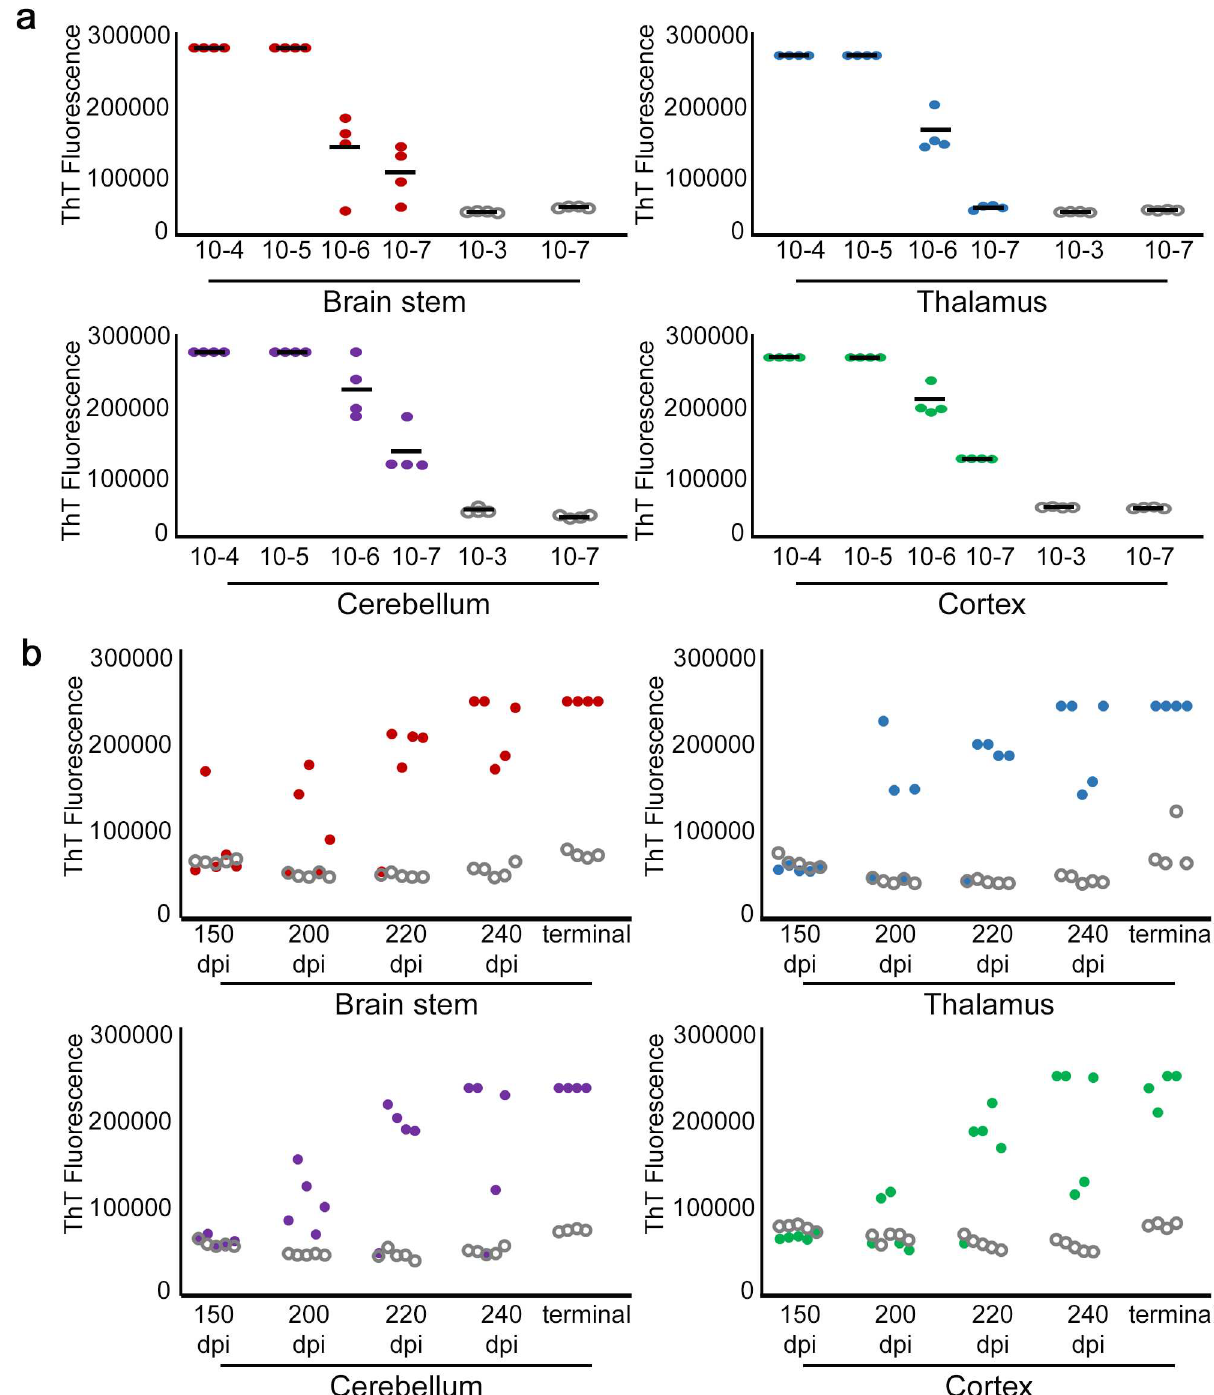
Fig 5. Neither quantity nor time of exposure of misfolded prion seeds are responsible for restrictedneurodegeneration. (a) RT-QuIC titration of brain regionhomogenates ( n = 4) shows that all brain regions dilute to a concentration of at least 0.001%(w/v) of the wet sample weight (10 − 5 ). Data shown are the averageThT fluorescence levels after 60 h incubation in RT-QuIC of triplicate RT-QuIC reactions. Grey opendots represent NBH/101LL region-matched controls. (b) RT-QuIC run on GSS/101LL brain regionsat several time-points throughout the incubation period. Each sample was run at a concentration of 0.1% (w/v) of the wet sample weight (10 − 3 ) for n = 5 GSS/ 101LLand NBH/101LLmice at each time-point, with exceptionof clinical(terminal) stage of disease( n = 4) and run in triplicate RT-QuIC reactions. Grey open dots demonstrate averageThT fluorescence of NBH controls ( n = 5) at each time-point. Data shown are the ThT fluorescence levels after 48 h incubationin